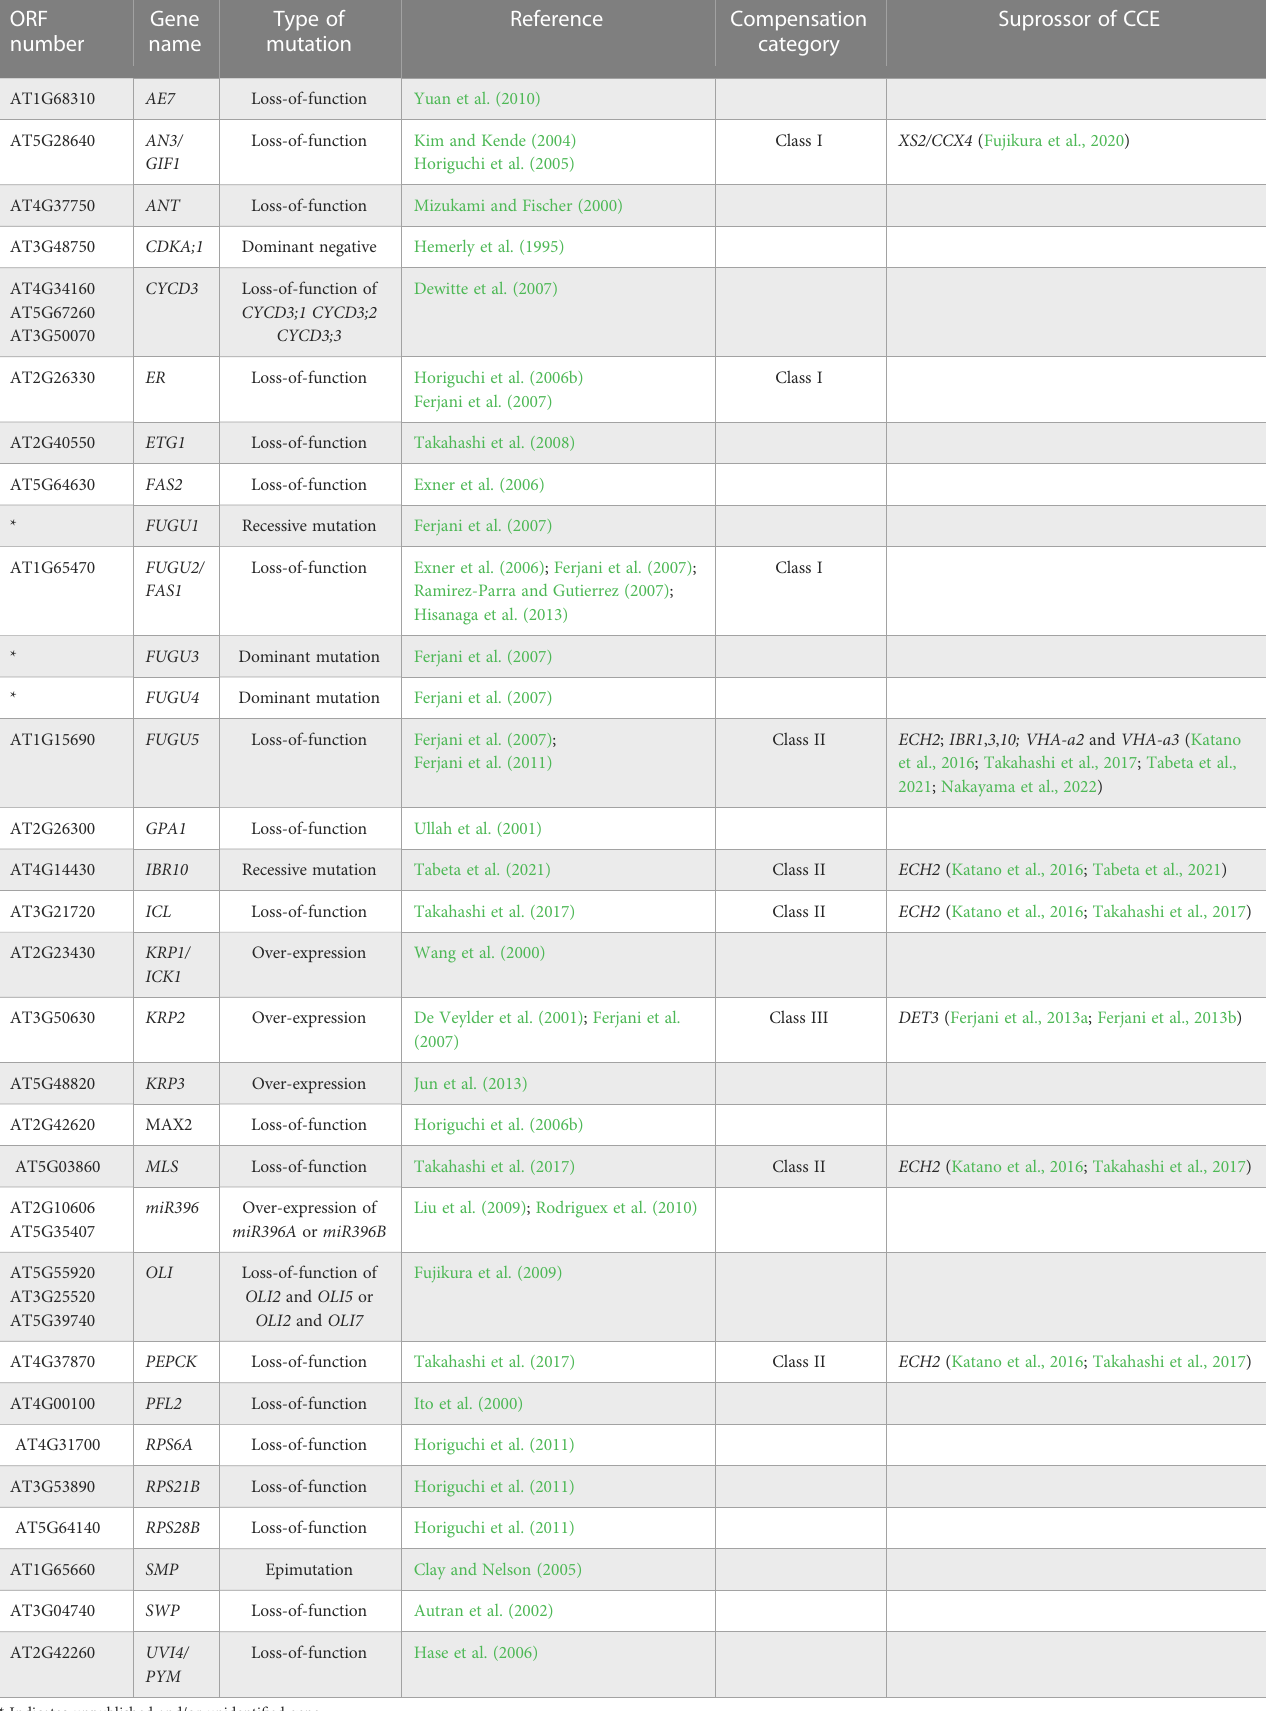
TABLE 1 List of compensation-exhibiting mutants, transgenic plants and their related